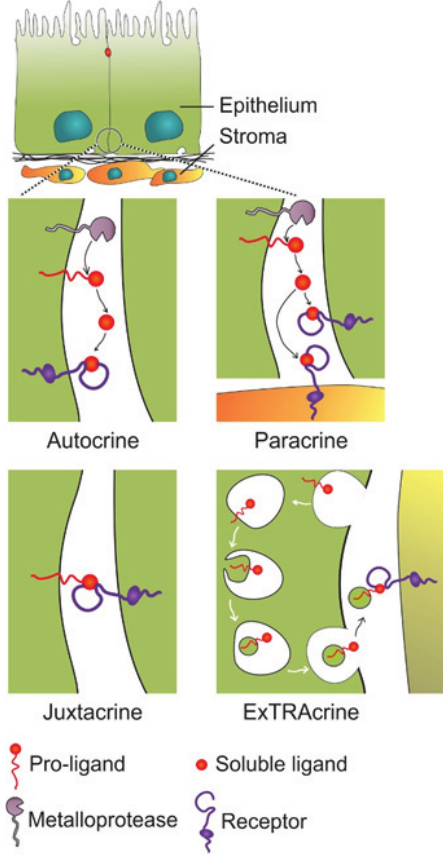
Figure 1. Modes of signaling via epidermal growth factor receptor (EGFR) ligands. Autocrine signaling occurs when a ligand is released from a cell and binds to EGFR on that same cell. Paracrine signaling refers to the released ligand acting on a nearby cell, usually a different cell type. Juxtacrine signaling occurs when a non-cleaved, transmembrane ligand binds to EGFR on an adjacent cell; this is best documented for heparin-binding epidermal growth factor-like growth factor (HBEGF). Amphiregulin (AREG), transforming growth factor-alpha (TGFA), and HBEGF, as well as EGFR, can be packaged into signaling competent exosomes. Uptake of exosomal AREG by recipient cells is, at least in part, dependent on EGFR, leading to the term exosomal targeted receptor activation (ExTRAcrine). ExTRAcrine signaling has features of autocrine, paracrine, and juxtacrine signaling as well as possibly endocrine signaling since EGFR and AREG can be detected in human plasma exosomes 30 . Adapted from Singh and Coffey 36